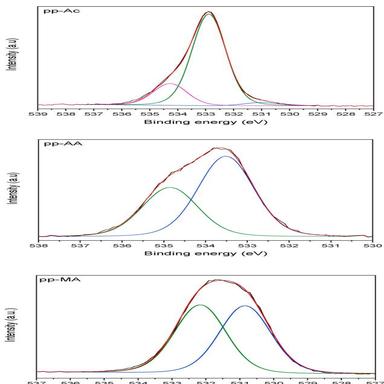
O 1s high resolution spectra of pp-Ac, pp-AA, pp-MA prepared in optimal operating parameters.